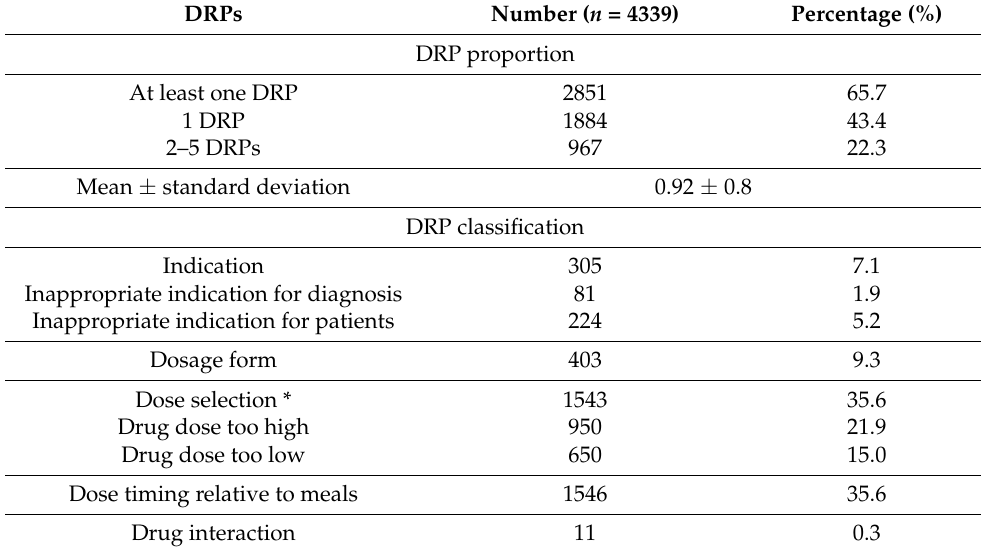
Table 3. DRPs in prescribing.